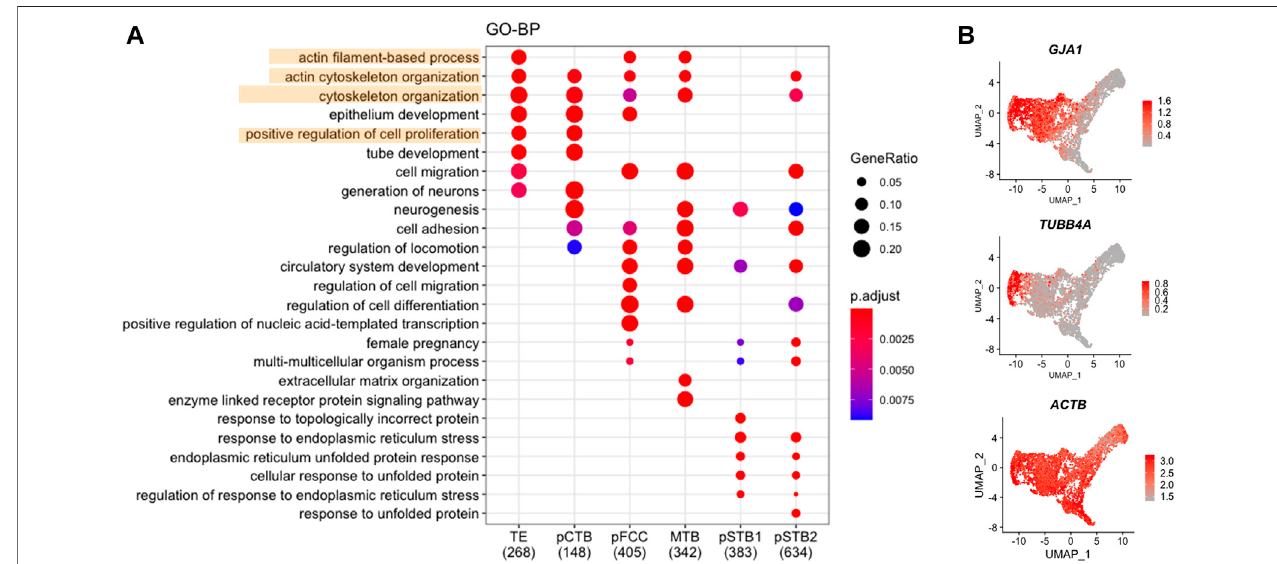
FIGURE3| Cytoskeleton-associatedgenesdecreasedinprimitivesyncytiotrophoblast. (A) DotplotsshowingenrichedGOtermsand p -valueofdistinctclustersof trophoblast cells. (B) UMAP plots showing the expression levels of representative genes for trophoblast cells. Color key from grey to red indicates relative expression levels from low to high,